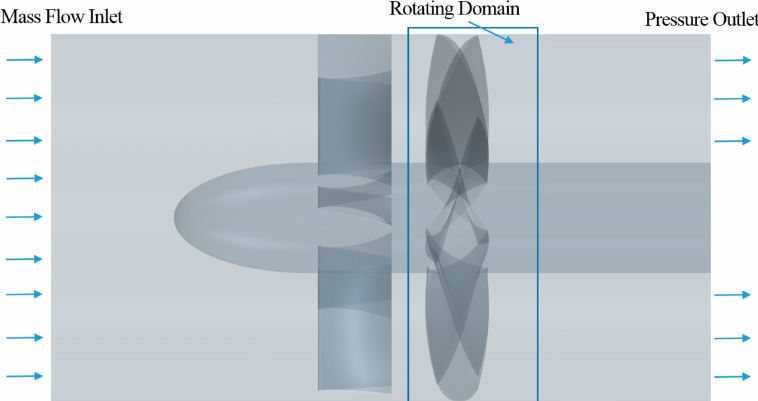
Figure 2. The computational domain for the axial-flow pump. The domain is a circular cylinder bounded by the shroud surface, 16 times the shroud diameter in length. The rotor is located at the longitudinal center of the domain, while the stator is located upstream of the